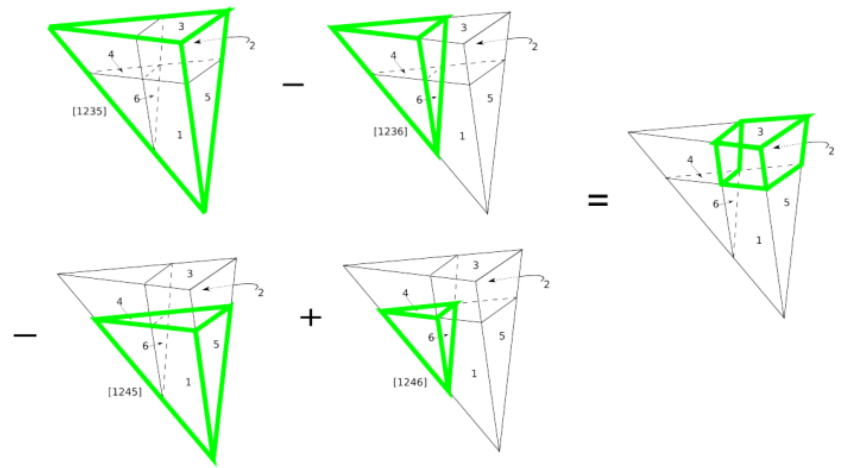
Figure 7 . A triangulation of the cube using four